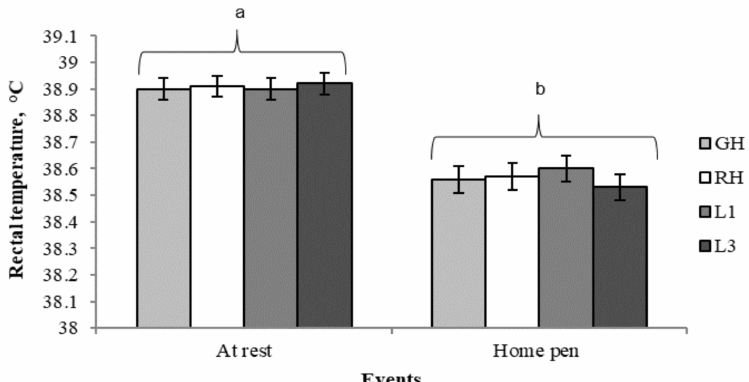
Figure 5. Least square means ( ± SEM) of rectal temperature measured at rest and on the return to the home pen. Least square means without a common superscript di ff er (Tukey’s test; P < 0.001).